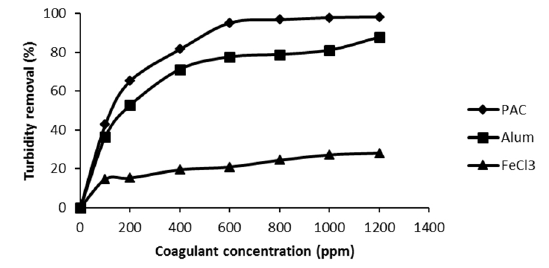
Figure 2. The consequences of the Jar test in the interval of turbidity removal for different PAC, Alum, FeCl 3 concentrations